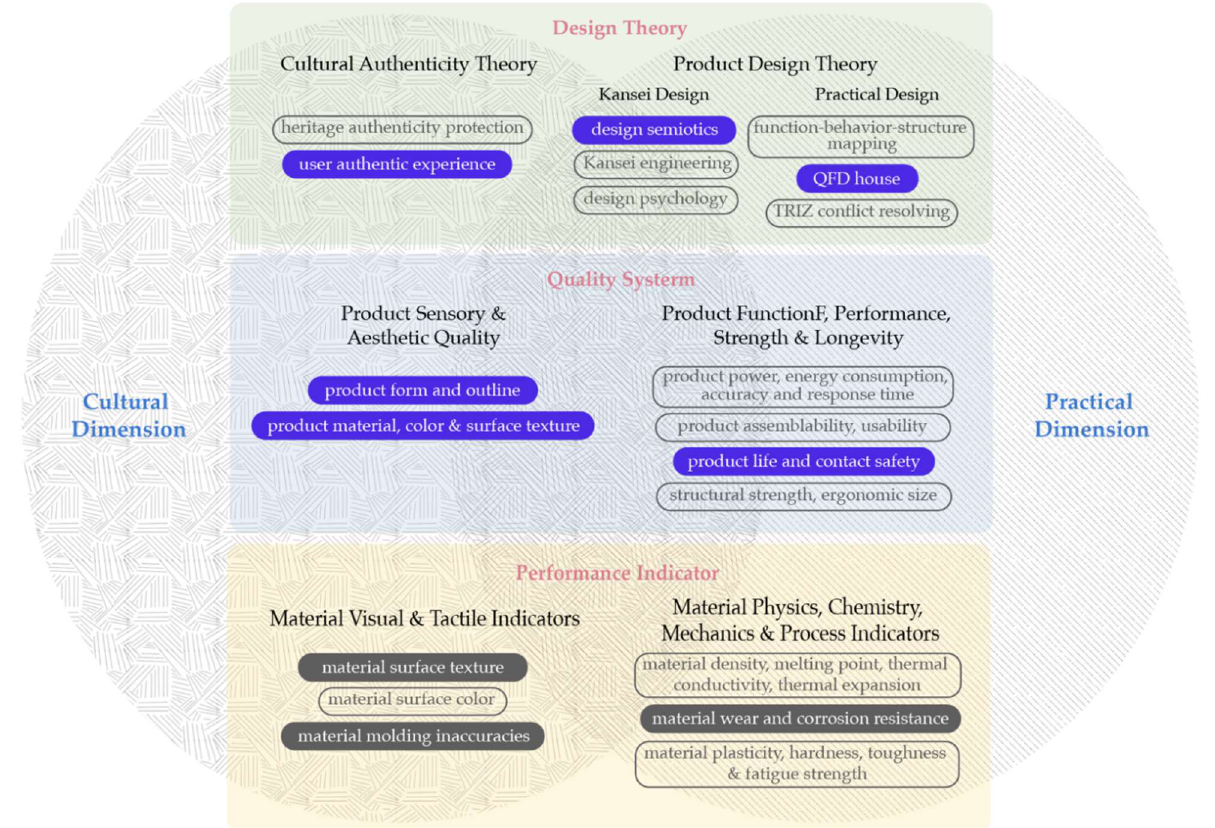
Figure 1. Material index derivation of historical buildings’ cultural innovation products.